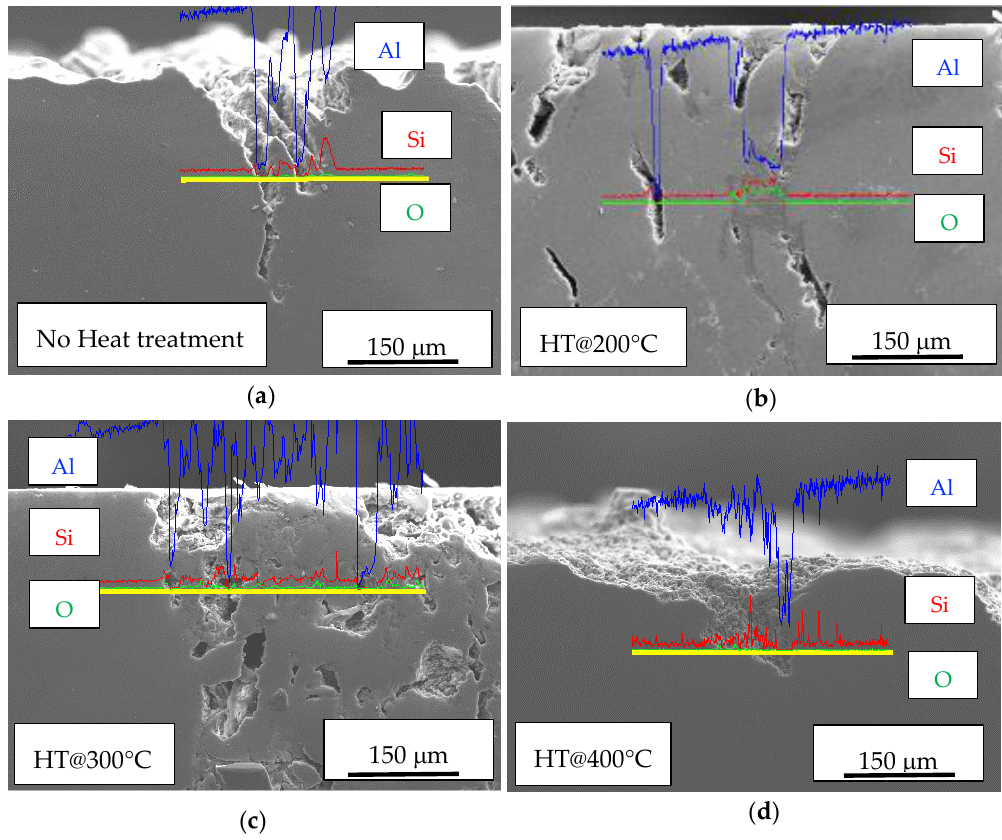
Figure 3. Energy dispersive X-ray spectroscopy (EDS) profile of aluminum (blue line), silicon (red line), and oxygen (green line) in the correspondence of attacks on specimens ( a ) not heat treated; ( b ) treated at 200 °C for 2 h; ( c ) treated at 300 °C for 2 h; ( d ) treated at 400 °C for 2 h.